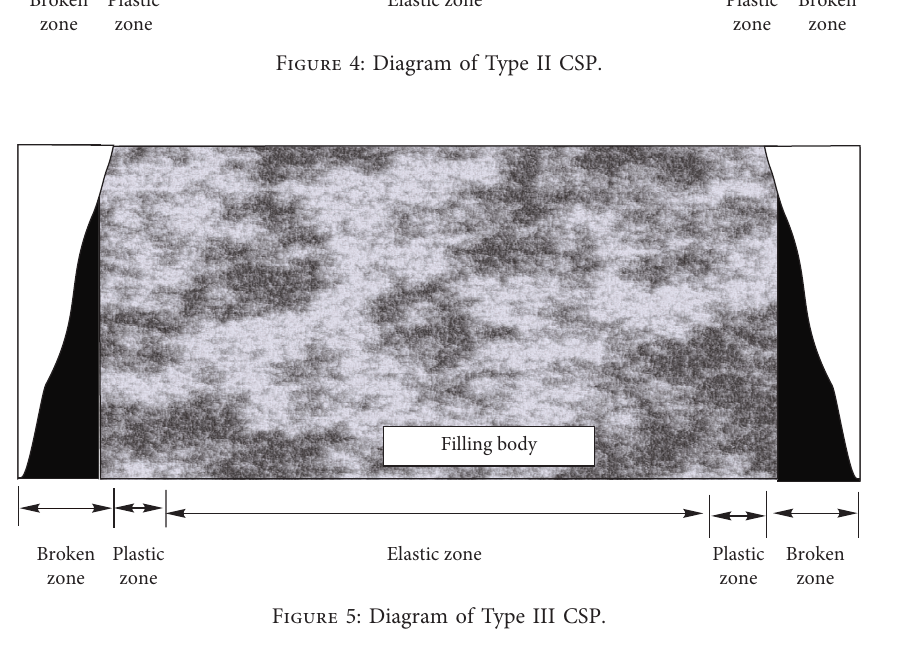
Figure 5: Diagram of Type III